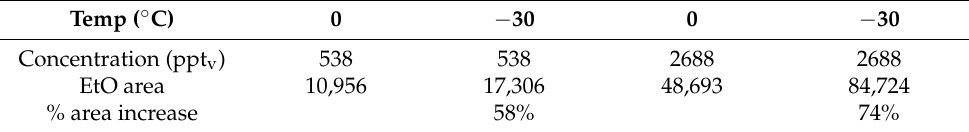
Table 2. EtO response vs. focusing trap temperature. 1 sample for each data point.